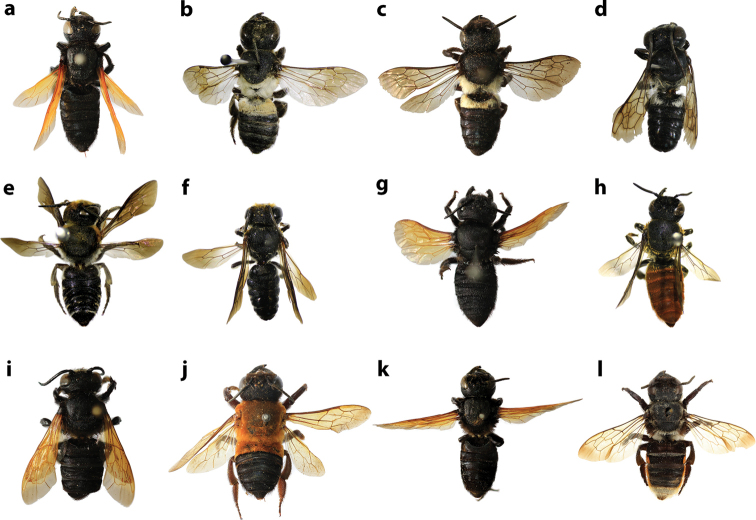
Dorsal view of some Thai Callomegachile (a–c, e, g, h, j–l females, d, f, i males) aM. (Callomegachile) atratiformisbM. (Callomegachile) chiangmaiensis sp. nov. c, dM. (Callomegachile) disjunctae, fM. (Callomegachile) facetagM. (Callomegachile) fulvipennishM. (Callomegachile) impressaiM. (Callomegachile) memecylonaejM. (Callomegachile) monticolakM. (Callomegachile) odontophoralM. (Callomegachile) ornata.